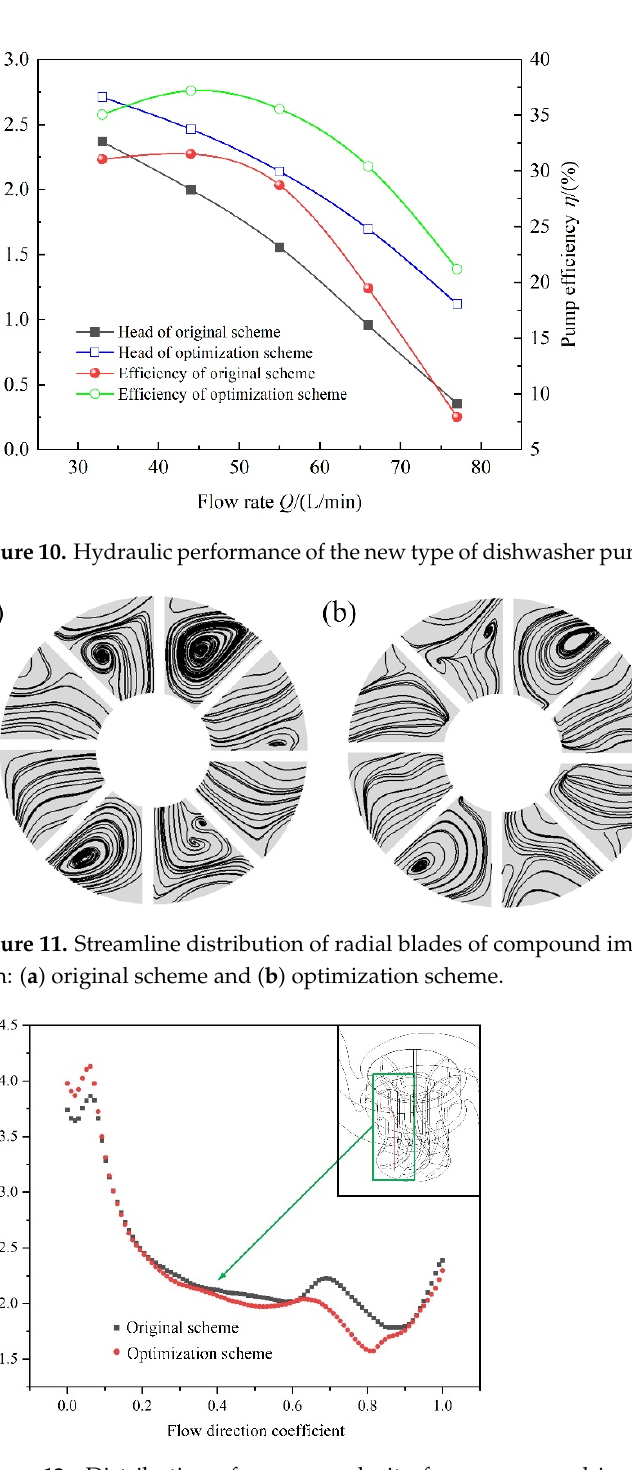
Figure 12. Distribution of average velocity from compound impeller inlet to outlet before and after optimization.